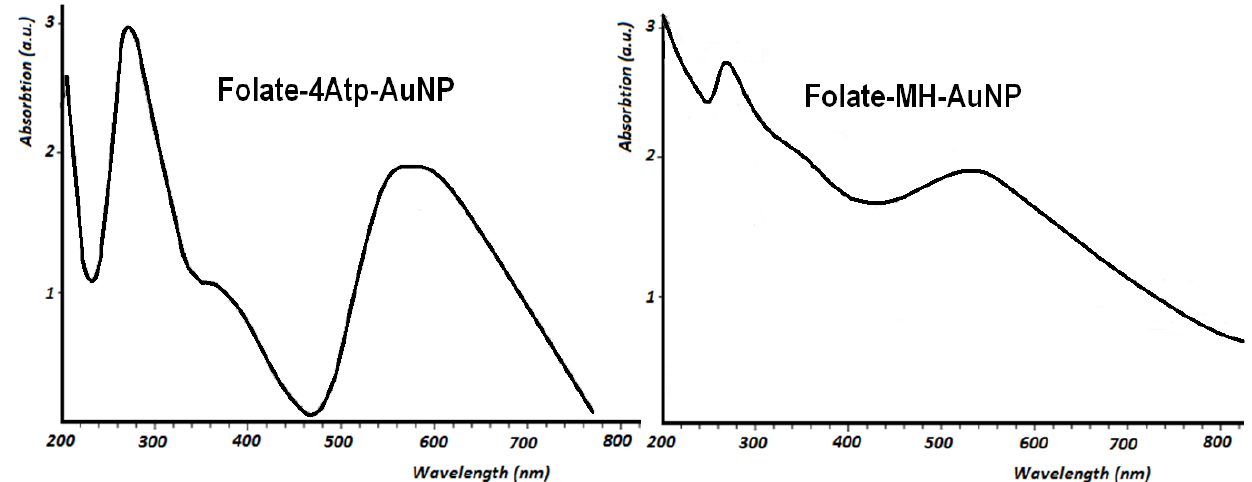
Figure 5. UV-Visible absorption spectra of Folate-4Atp-AuNP [25-27] and Folate-MH-AuNP [28,29]